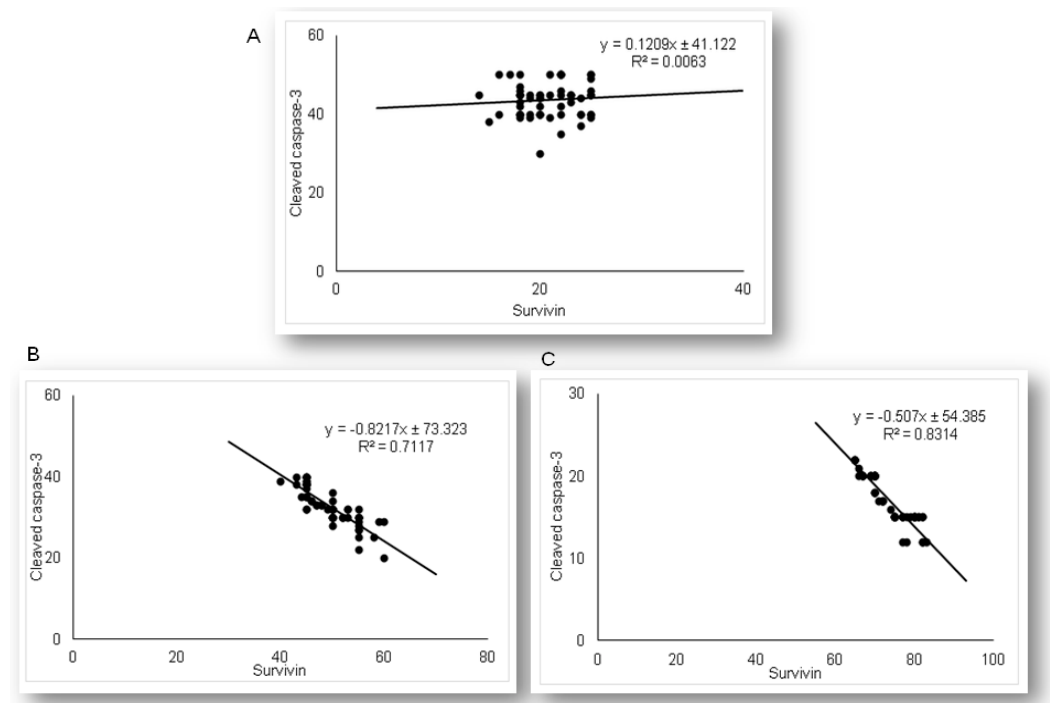
Figure 9. The correlations are shown for survivin and cleaved-caspase-3 in the renal tubular epithelial cells: ( A ) LPS group only, ( B ) simvastatin 20 mg/kg group, ( C ) simvastatin 40 mg/kg group.